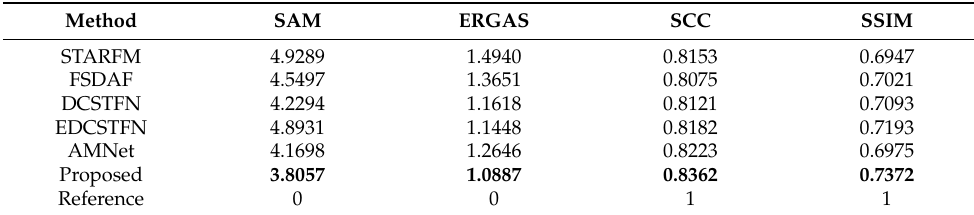
Table 3. Index performance of each method on the CIA dataset.